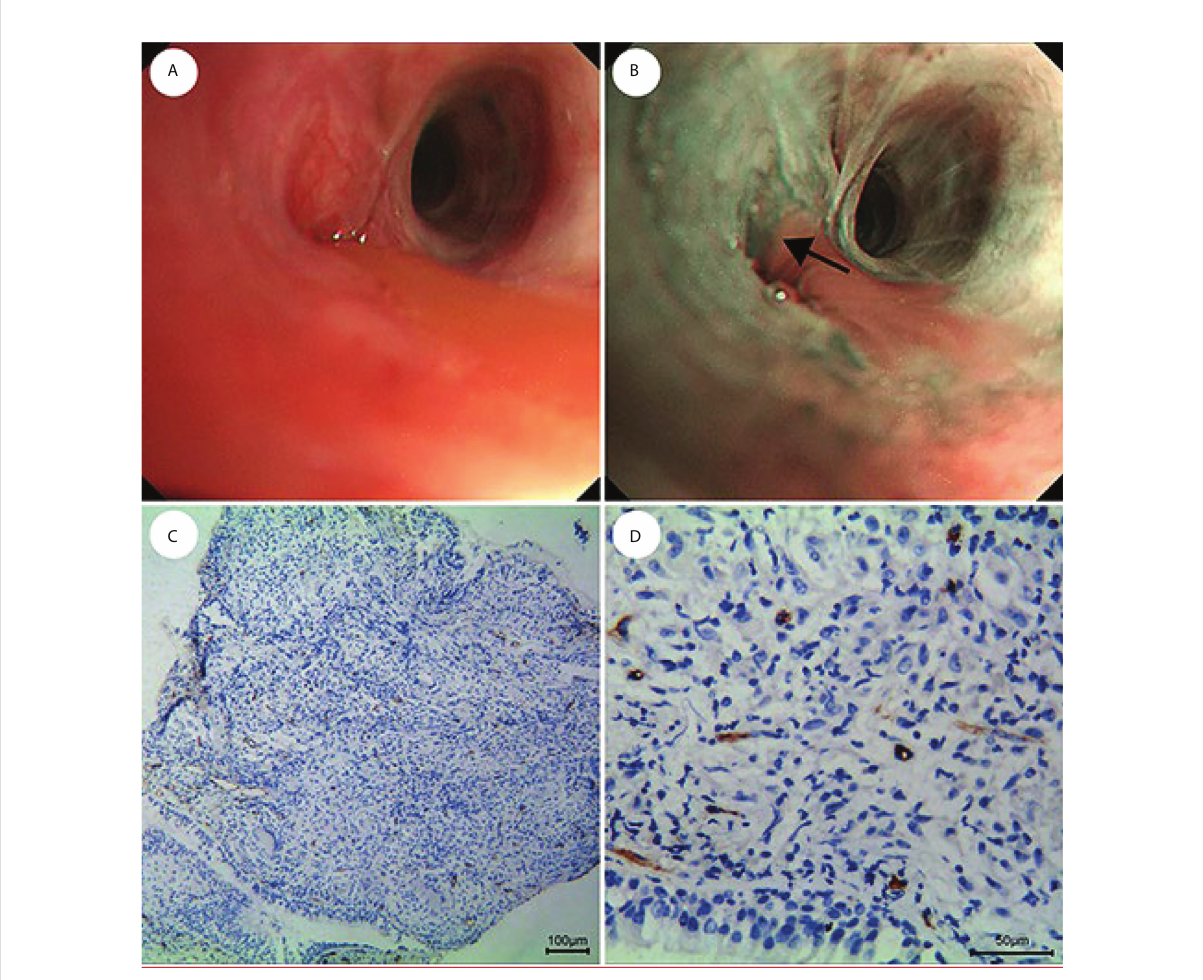
FIGURE 7 Fewer and regular blood vessels in in fl ammation of the lung. (A) WLB image. (B) NBI shows that there are fewer and regular blood vessels. (C, D) IHC staining of the tissue specimen shows that there are fewer and regular blood vessels [the scale of (C) is 100 m m, the scale of (D) is 50 m